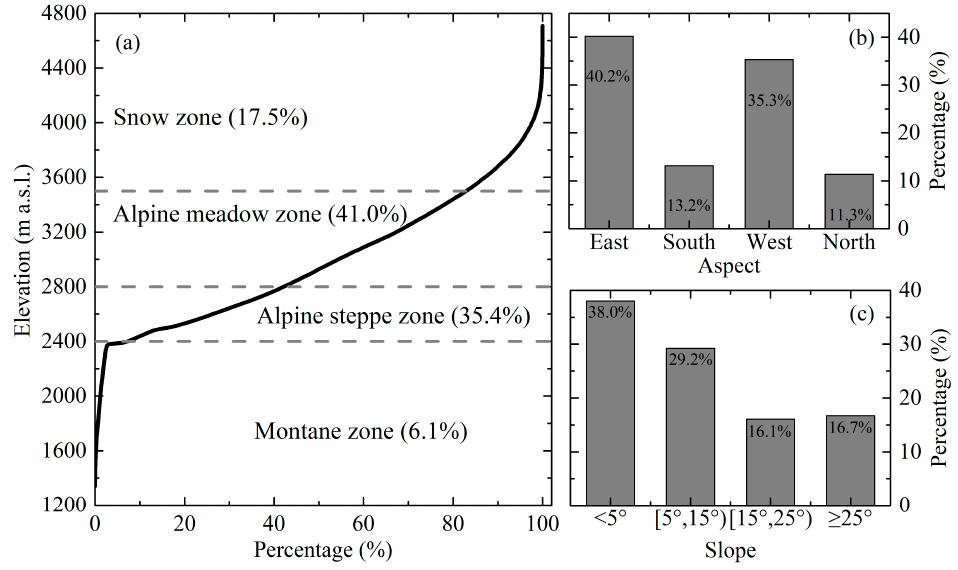
Figure 2. The topographic characteristics of the study area. ( a ) Plot of percentage distribution with an elevation over the KRB; ( b ) The percentage distribution of slope aspects; ( c ) The percentage distribution of slopes.